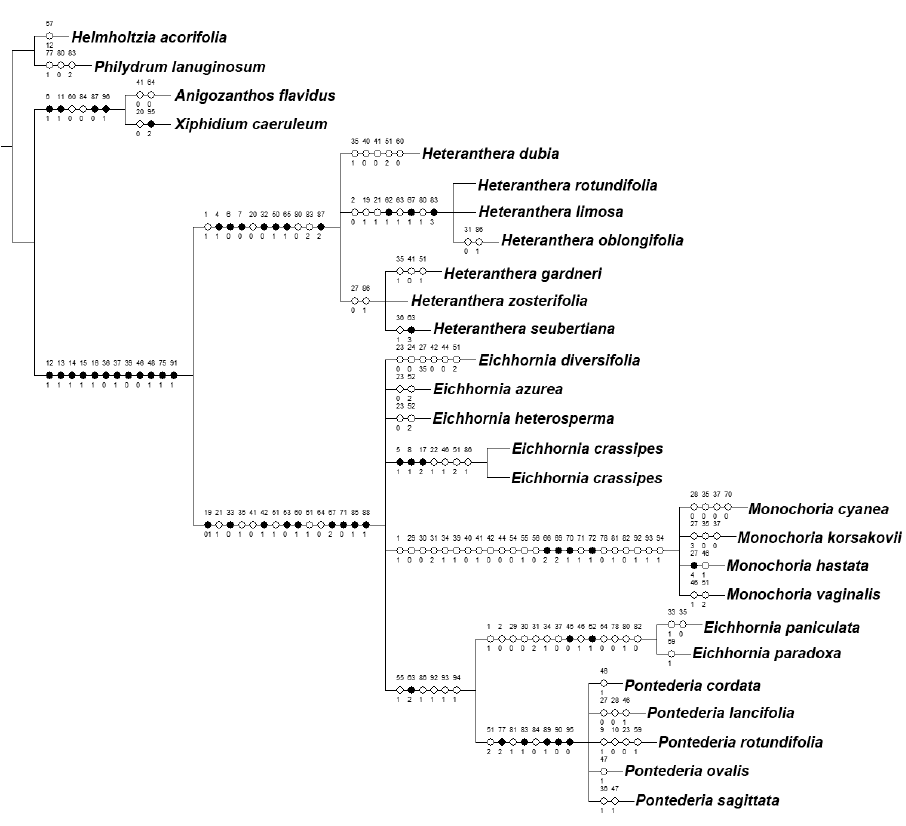
Figure 1. Strict consensus tree (length=209 steps; CI=0.5913; RI=0.8618) recovered by the morpho- logical dataset, showing the character state optimisations at each node of the cladogram, represented by circles. In each circle, the numbers above and below represent the character and character state numbers, respectively (as presented in Suppl. material